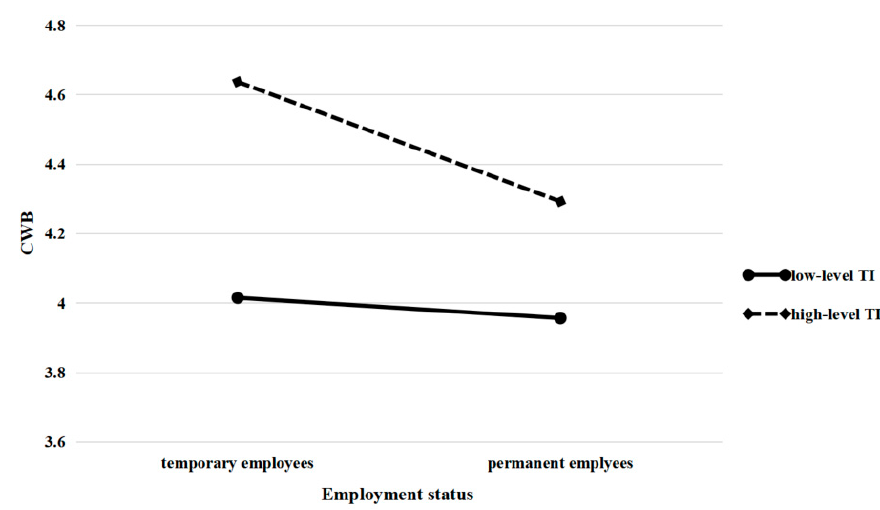
Figure 2. Interaction between employment status and turnover intention on organization identifi- cation.